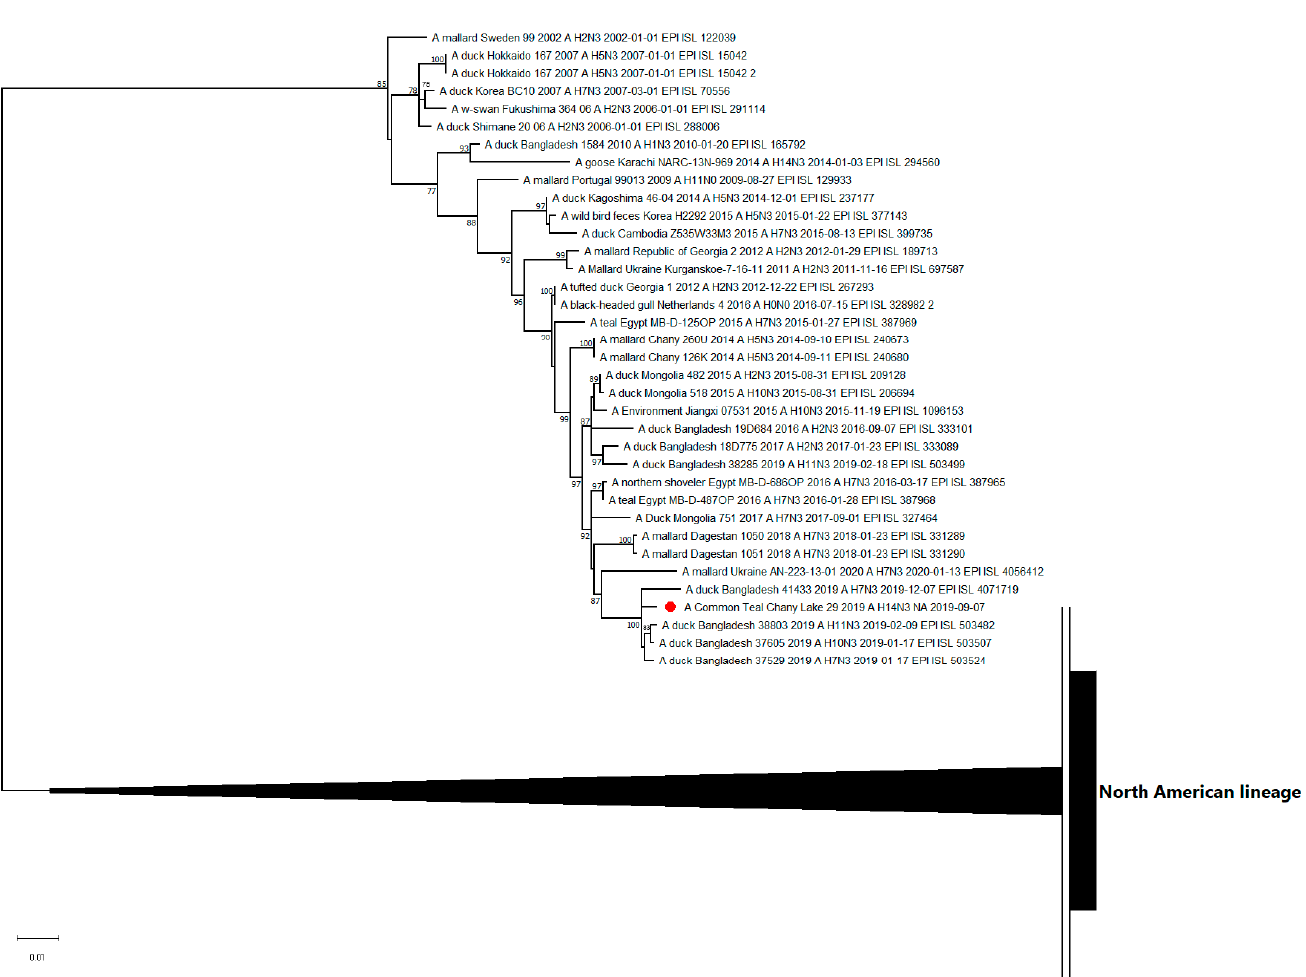
Figure 3. Maximum likelihood phylogenetic tree of the NA-subtype N3 genome segment of avian influenza viruses ( ● —sequence from this study).